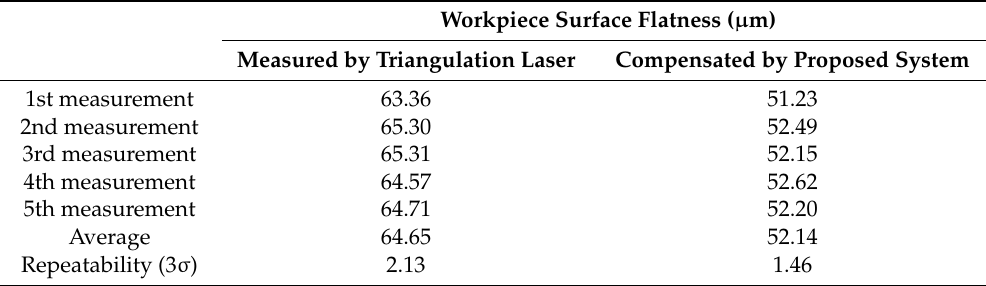
Table 5. Compensation result of surface flatness by the proposed